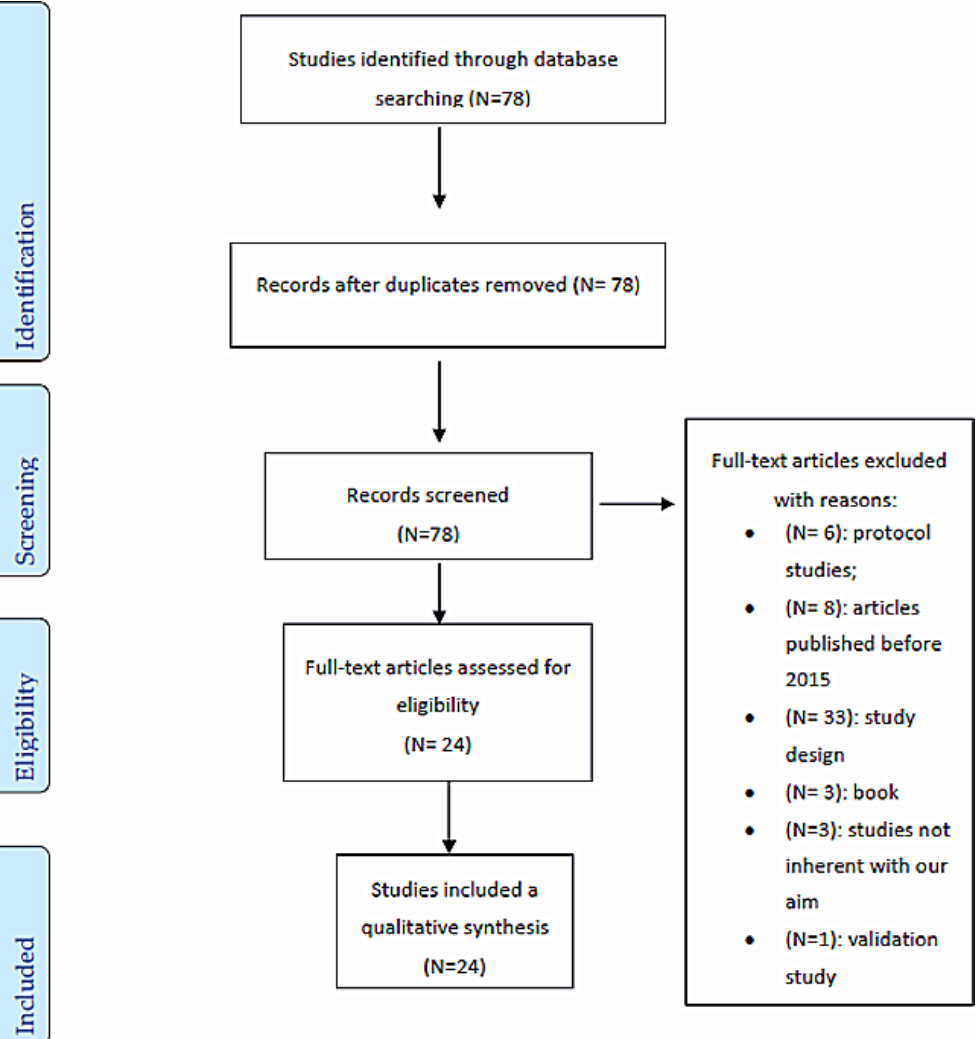
Figure 1. Flow chart of studies selection according to PRISMA guidelines [13].